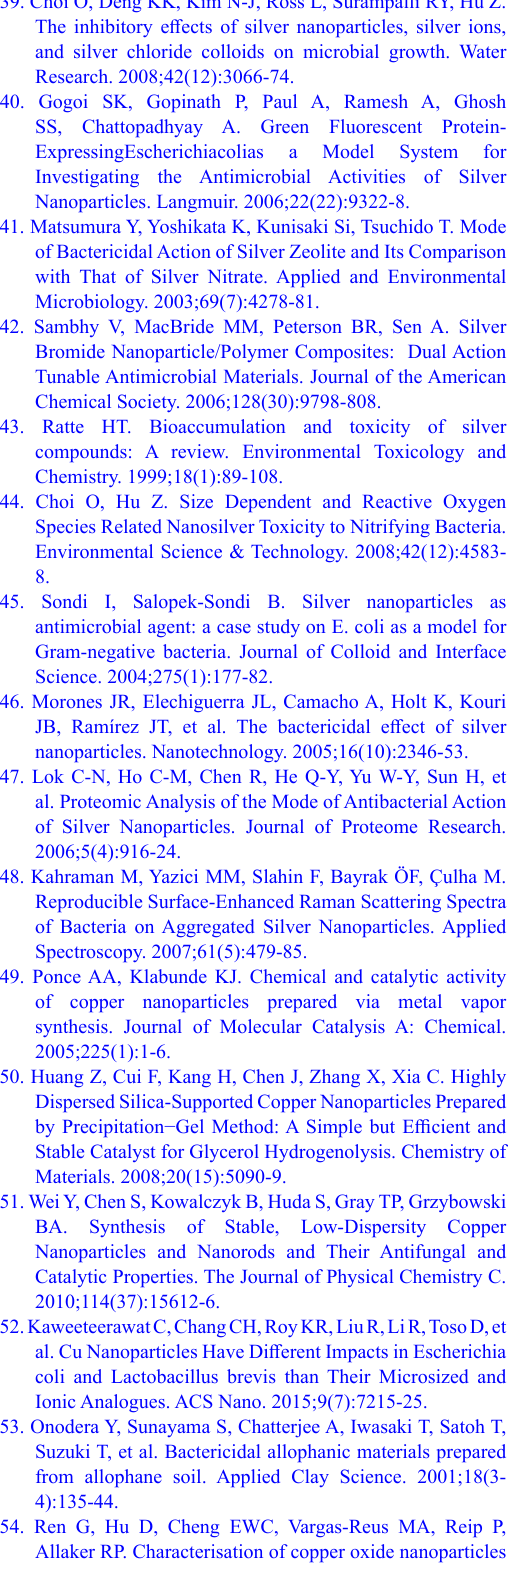
177 Nanochem Res 4(2): 170-178, Summer and Autumn